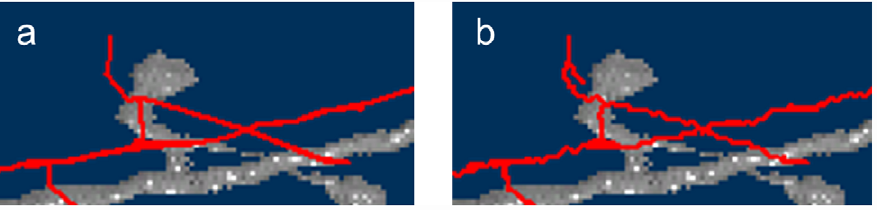
Figure 13. A zoom-in view of the traced result. Red lines show the tracing results. The lines in (a) are zigzag shaped. However, they become smooth when the e -approximation method is applied (b). The e was ffiffiffi 3